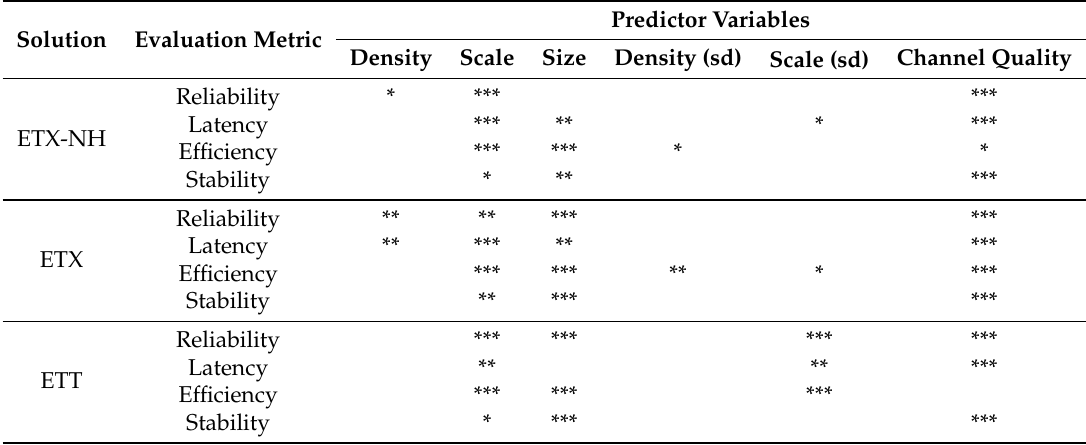
Table 2. The significant predictor variables for modelling the response of each evaluation metric as determined by a